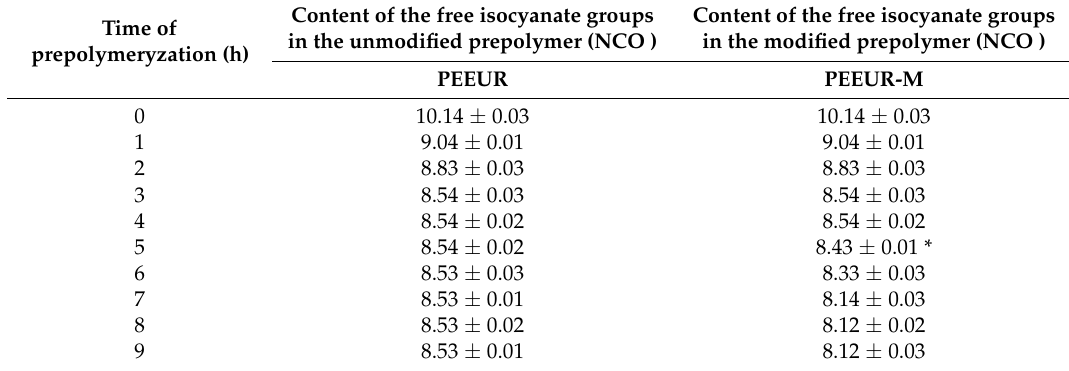
Table 1. The impact of the prepolymer modification time on the decrease of free isocyanate groups present in it. Time